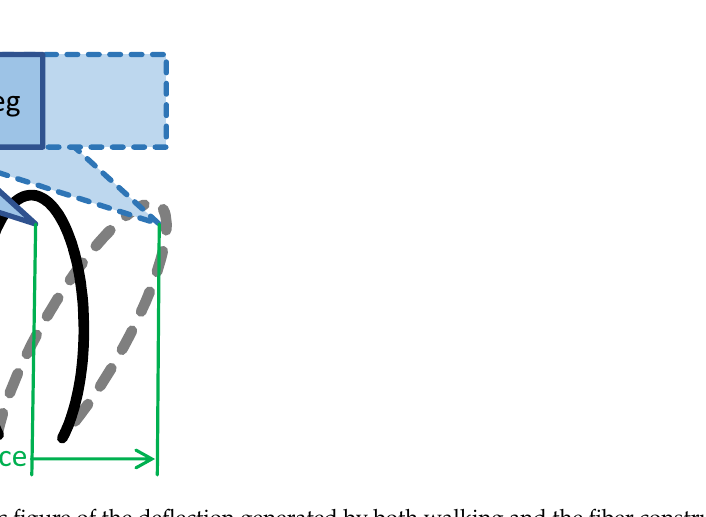
Figure 22. A schematic figure of the deflection generated by both walking and the fiber construction of the carpet. The supporting legs kicked the ground to walk, and the fibers were deflected. Due to this deflection, the robot moved backward